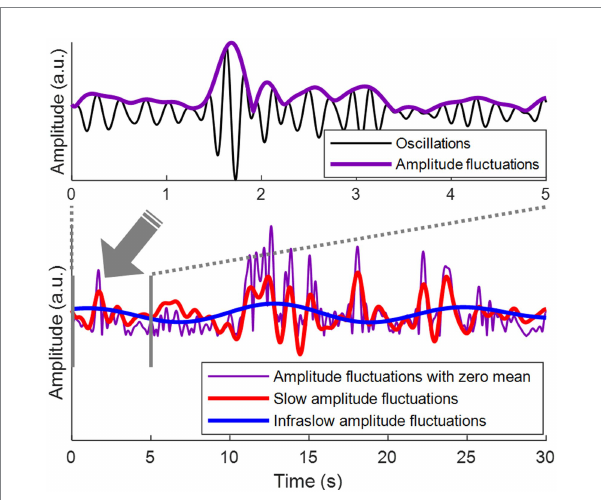
FIGURE 1 Amplitude fluctuations of EEG oscillations. (Top) Theta oscillations (3–7 Hz) are shown in black. Amplitude fluctuations of the theta oscillations (= the envelope of the theta oscillations) are shown in purple. (Bottom) The top panel is the first 5 s from the bottom panel. Amplitude fluctuations with zero mean are shown in purple. Slow amplitude fluctuations are obtained by bandpass filtering of amplitude fluctuations at 0.1–1 Hz, shown in red. Infraslow amplitude fluctuations are obtained by bandpass filtering of amplitude fluctuations at 0.05–0.1 Hz, shown in